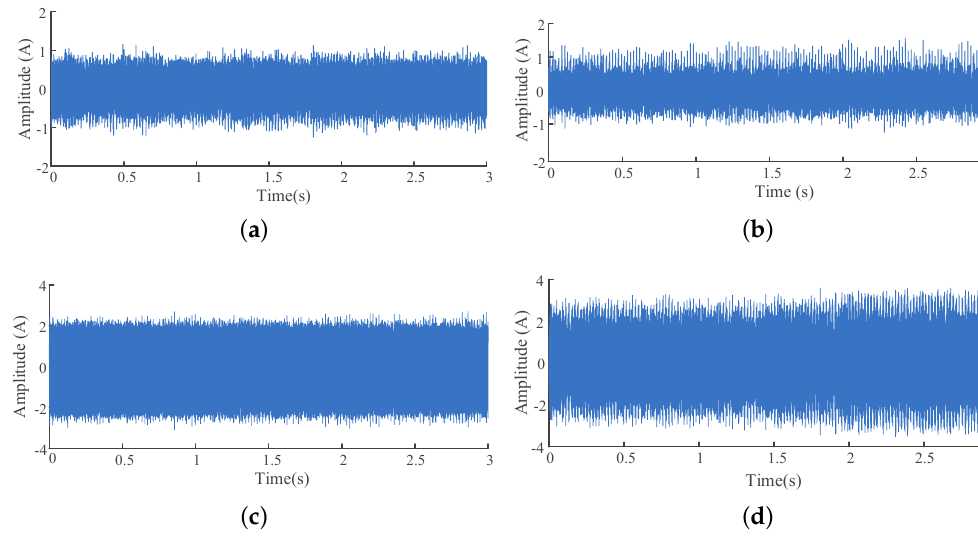
Figure 5. Vibration signals with four wear degrees. ( a ) vibration signal of slipper under normal condition; ( b ) vibration signal of slipper with slight wear; ( c ) vibration signal of slipper under moderate wear; ( d ) vibration signal of slipper under severe